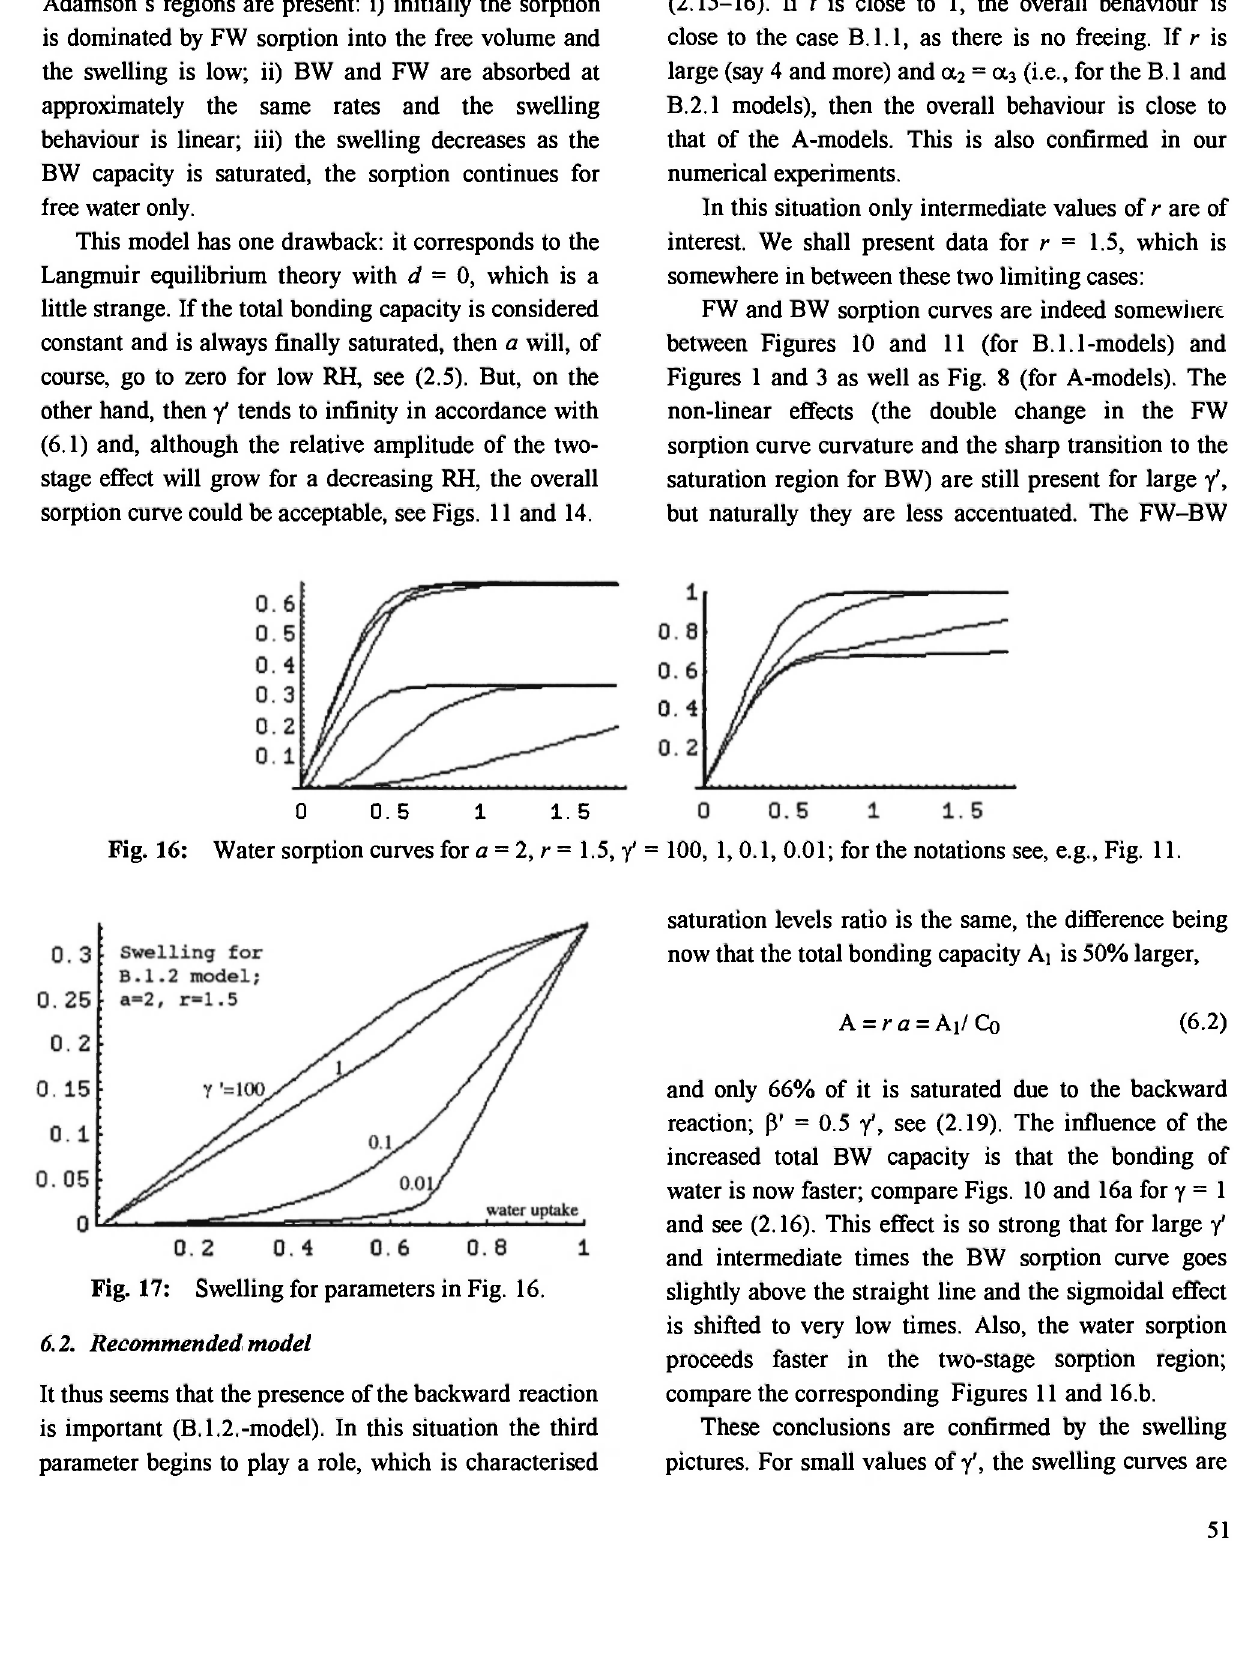
Fig. 16: Water sorption curves for a = 2, r = 1.5, γ'